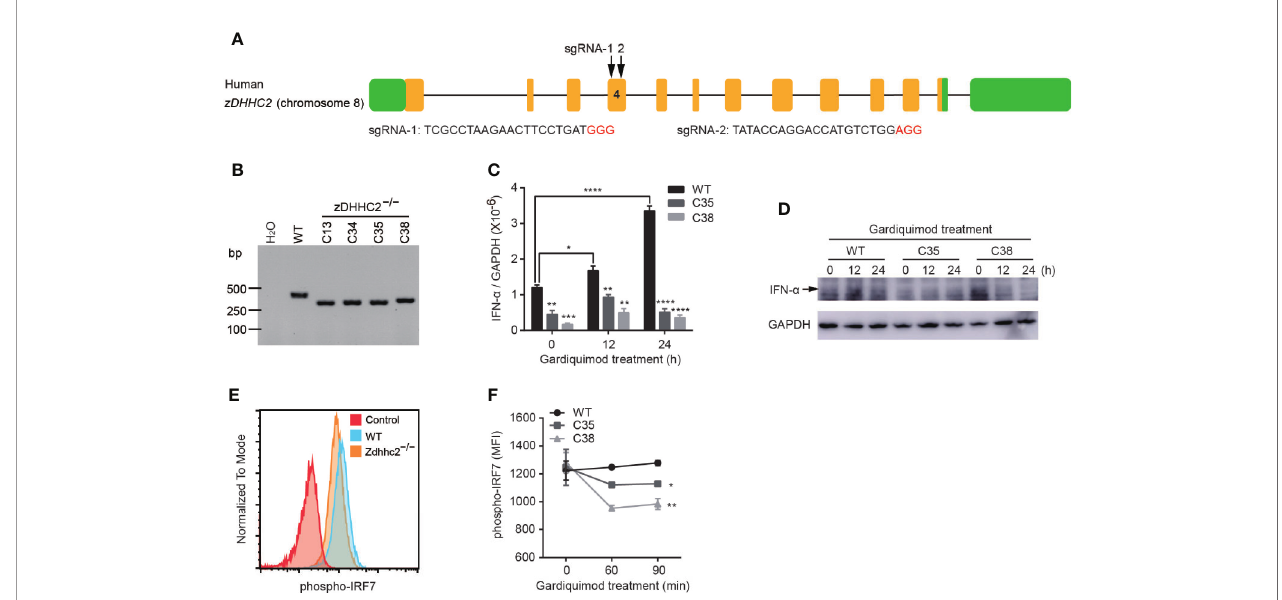
FIGURE 5 | Inhibition of IFN- a production through IRF7 phosphorylation in CAL-1 zDHHC2 − / − cells. (A) Schematic representation of sgRNA-1 and sgRNA-2 sequences used to target exon 4 of the zDHHC2 gene. Protospacer adjacent motif (PAM) sequences are shown in red color. (B) zDHHC2 de fi ciency clone C13, C34, C35, and C38 were selected by PCR and agarose electrophoresis. Results from CAL-1 zDHHC2 − / − cells are shown and compared to CAL-1 WT cells. H 2 O was used as negative control. (C, D) qRT-PCR and western blot analysis of IFN- a expression in CAL-1 WT and CAL-1 zDHHC2 − / − cells with or without gardiquimod stimulation. (E, F) Flow cytometry analysis of phospho-IRF7 in CAL-1 WT and zDHHC2 − / − cells after gardiquimod stimulation. (E) Representative histogram of IRF7 phosphorylation level at 60 min after gardiquimod stimulation. (F) MFI of phospho-IRF7 at 0, 60, and 90 min after gardiquimod treatment, compared between WT and zDHHC2 − / − cells (n = 3, mean ± SEM). * p < 0.05, ** p < 0.01, *** p < 0.001, **** p < 0.0001, unpaired Student ’ s t-